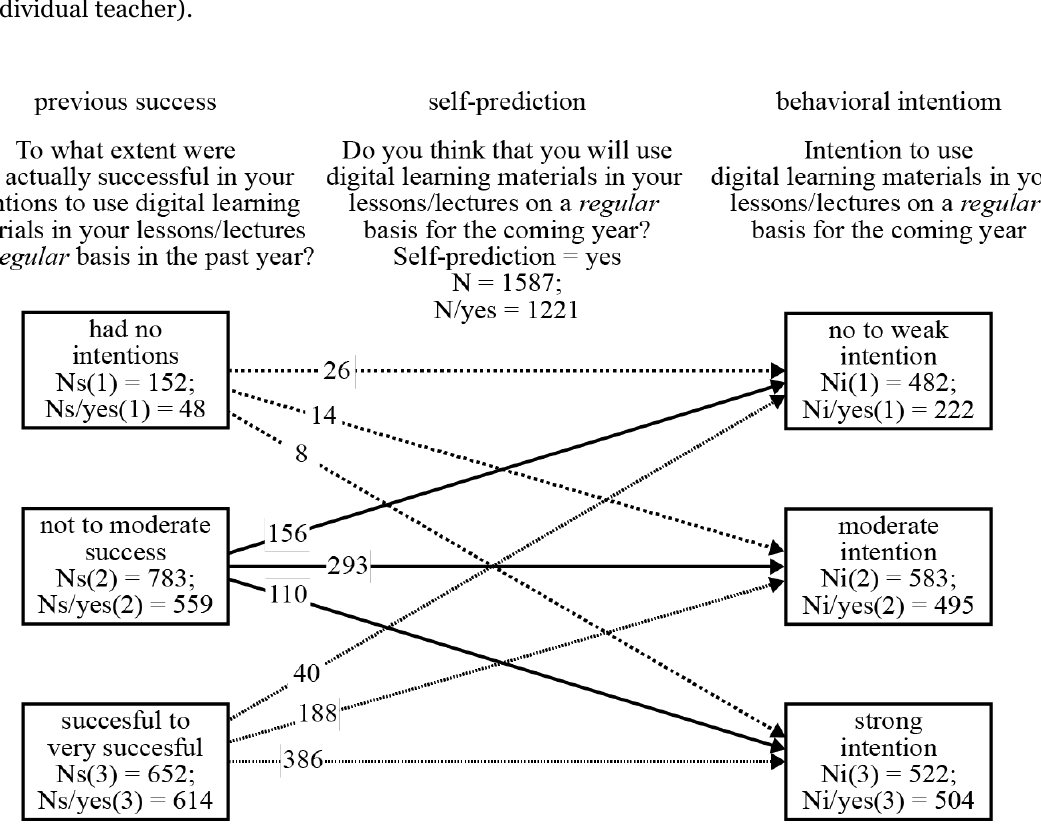
Figure 2a . Teachers flows for the population of teachers who predicted that they will use DLMs regularly during